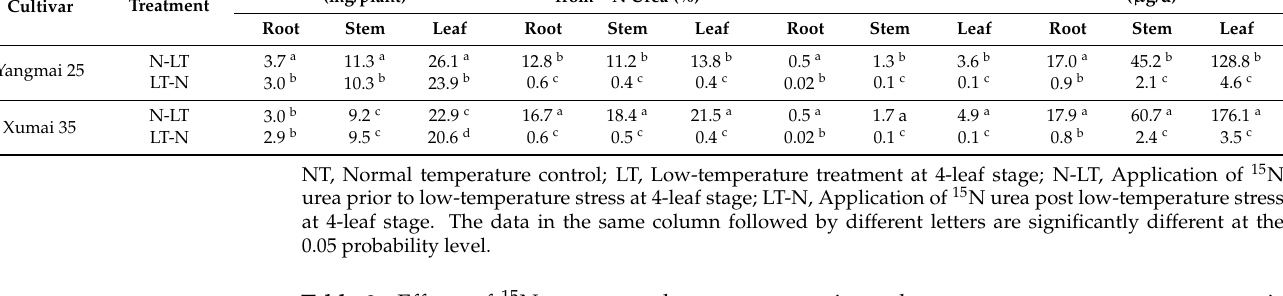
Table 3. Effects of 15 N urea amendment post or prior to low-temperature stress on agronomic characteristics of wheat